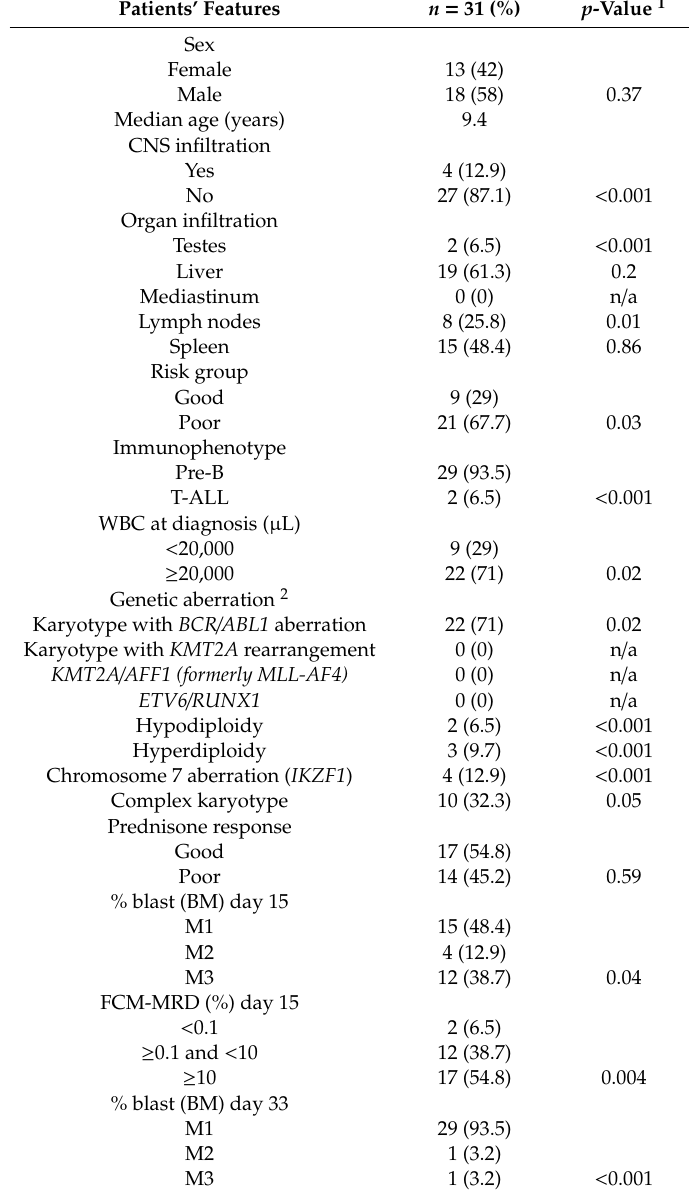
Table 1. Clinical characteristics of children with ALL Ph + (Philadelphia chromosome positive acute lymphoblastic